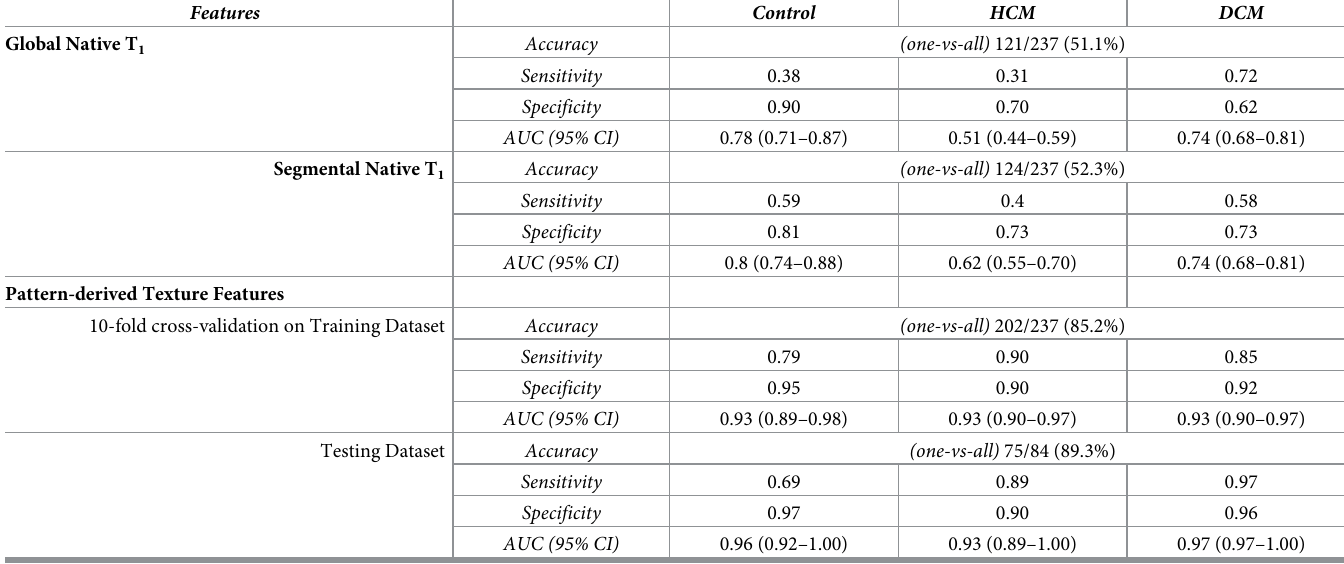
Table 4. Sensitivity and specificity of global native T 1 value and pattern-derived texture features to identify subjects in the three cohorts (i.e. control, HCM, and DCM) using multiclass linear SVM.